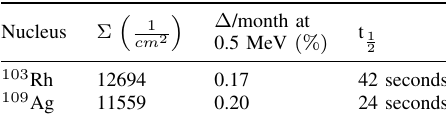
TABLE II T OP EMITTER CANDIDATES FOR DELAYED - TYPE SPND S LISTED IN ORDER OF SUITABILITY . T 1 REPRESENTS THE β - DECAY HALF LIFE OF 2 THE REACTION PRODUCT , BURNUP ( ∆ ) IS CALCULATED ASSUMING φ = 5 10 15 N / S / CM 2 . ×